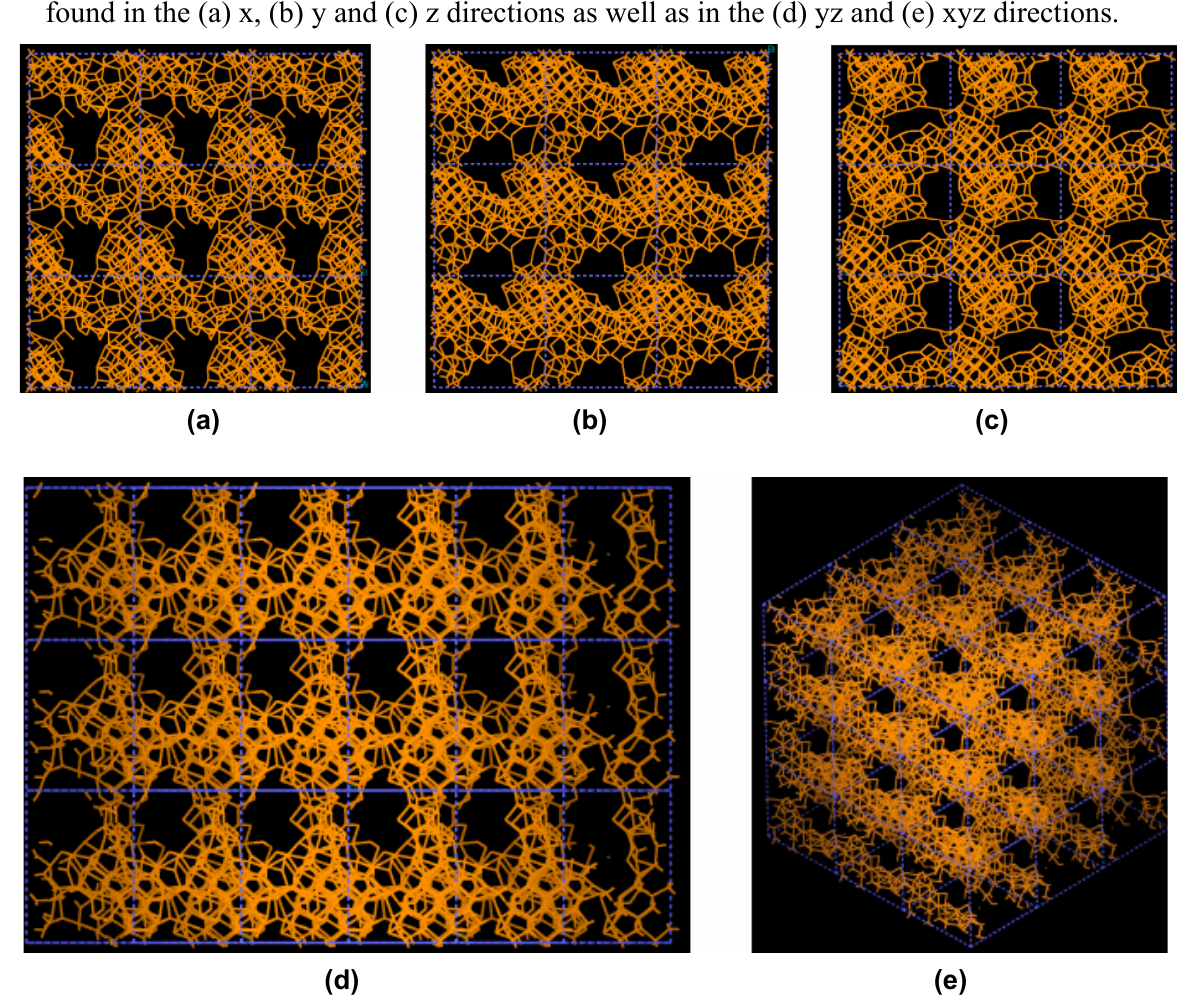
Figure 10. Pore structure obtained for 3 × 3 × 3 silicon cells. The through pores here are found in the (a) x, (b) y and (c) z directions as well as in the (d) yz and (e) xyz